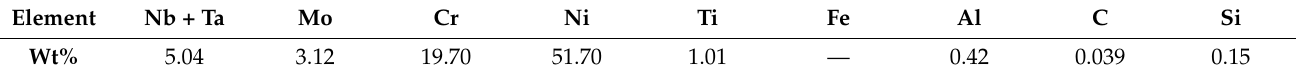
Table 1. Chemical components of GH4169 alloy.